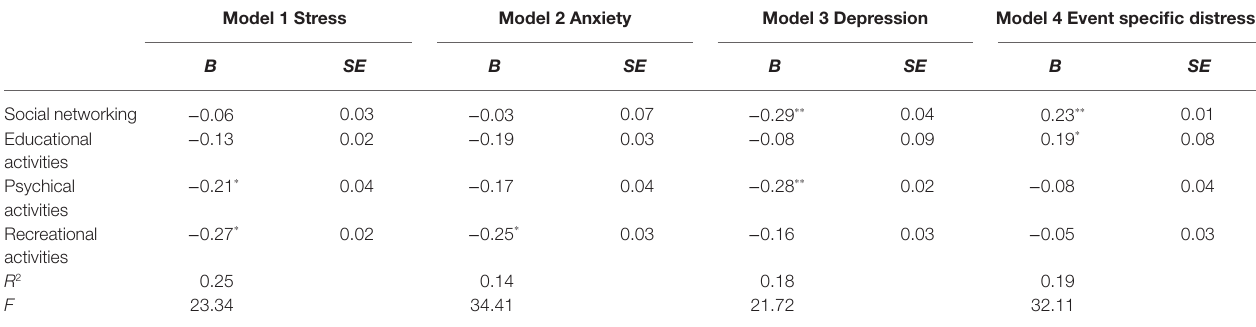
TABLE 3 | Connexion between home quarantine activities and psychological well-being and mental health of